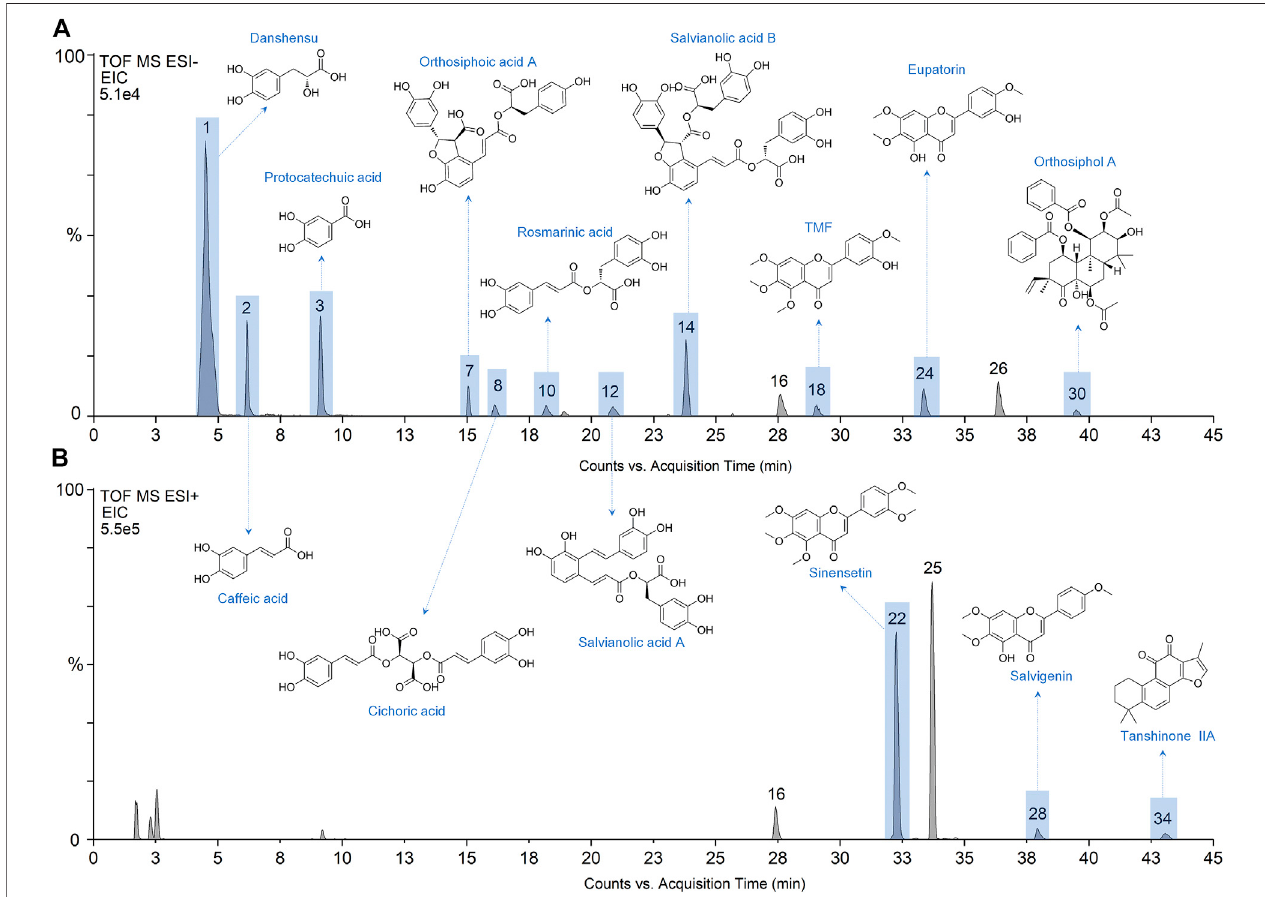
FIGURE 2 | Extracted ion chromatograms (EIC) of plasma samples from rats after administration ofOSB extract in negative mode (A) and positive mode (B) . OSB Orthosiphon stamineus Benth.